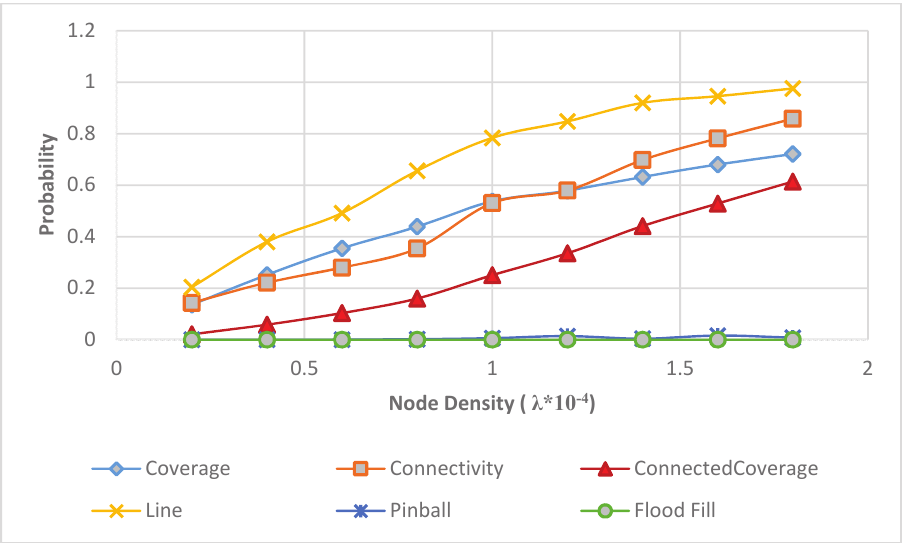
Figure 13. Probability of coverage, connectivity, connected coverage and the detection probabilities of a random WSN with varying node densities λ